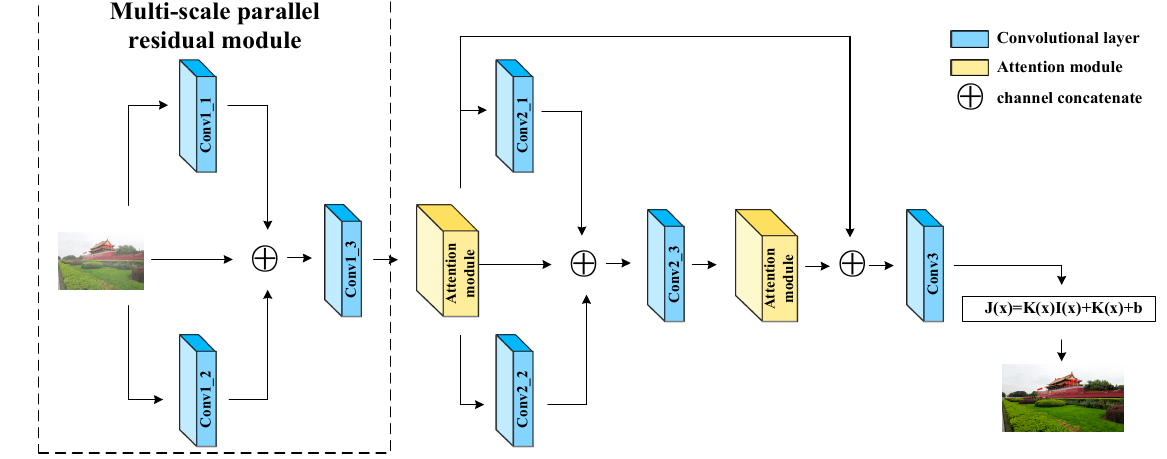
Figure 1. Architecture of the proposed Transformer for image dehazing (TID).